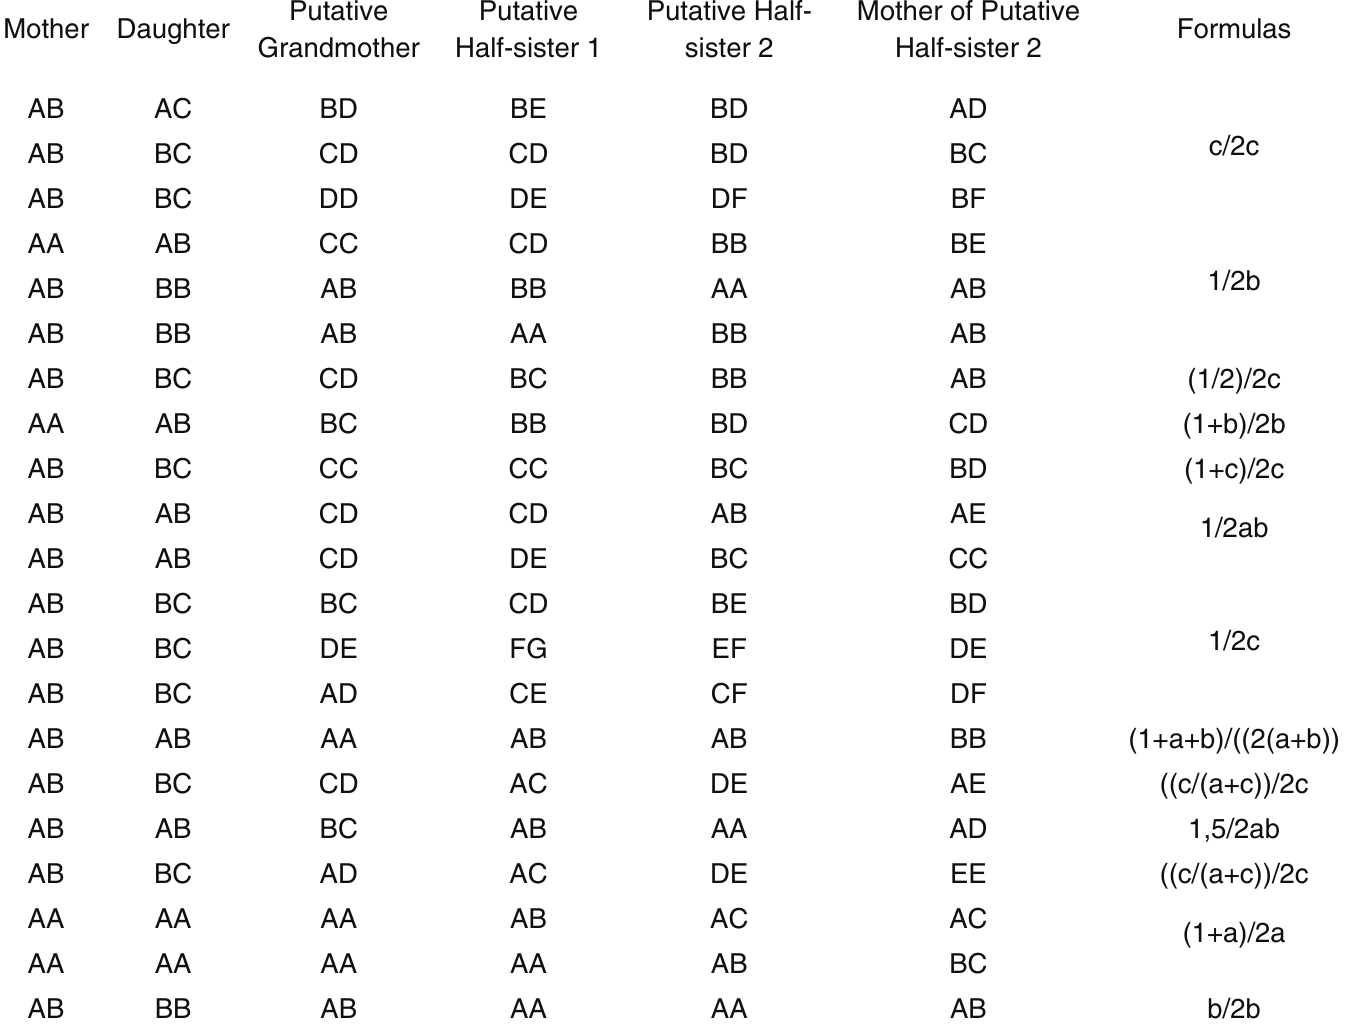
Table S4 - Formulas to calculate PI considering the profile configurations depicted with AS STRs, in case